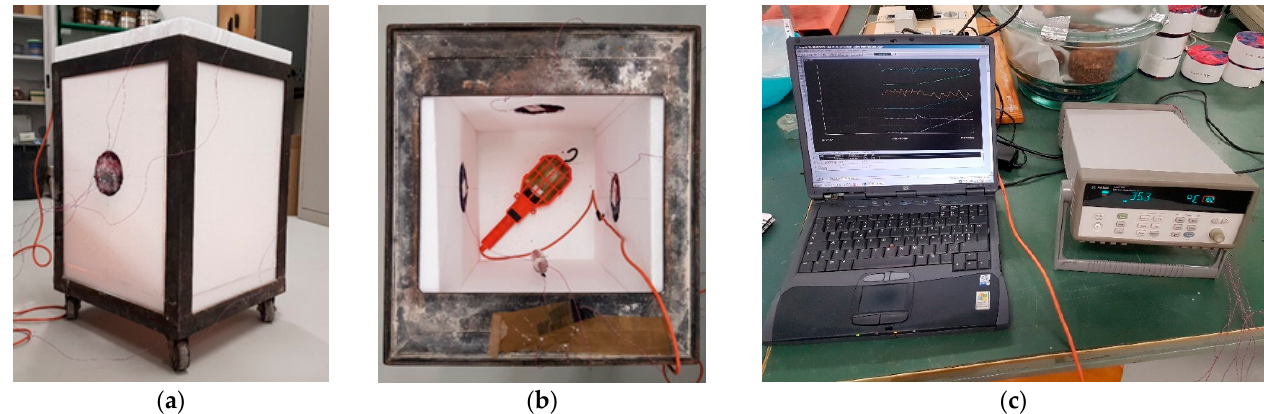
Figure 9. The Hot Box seen from the outside ( a ), from the inside ( b ) and data acquisition setup ( c ).